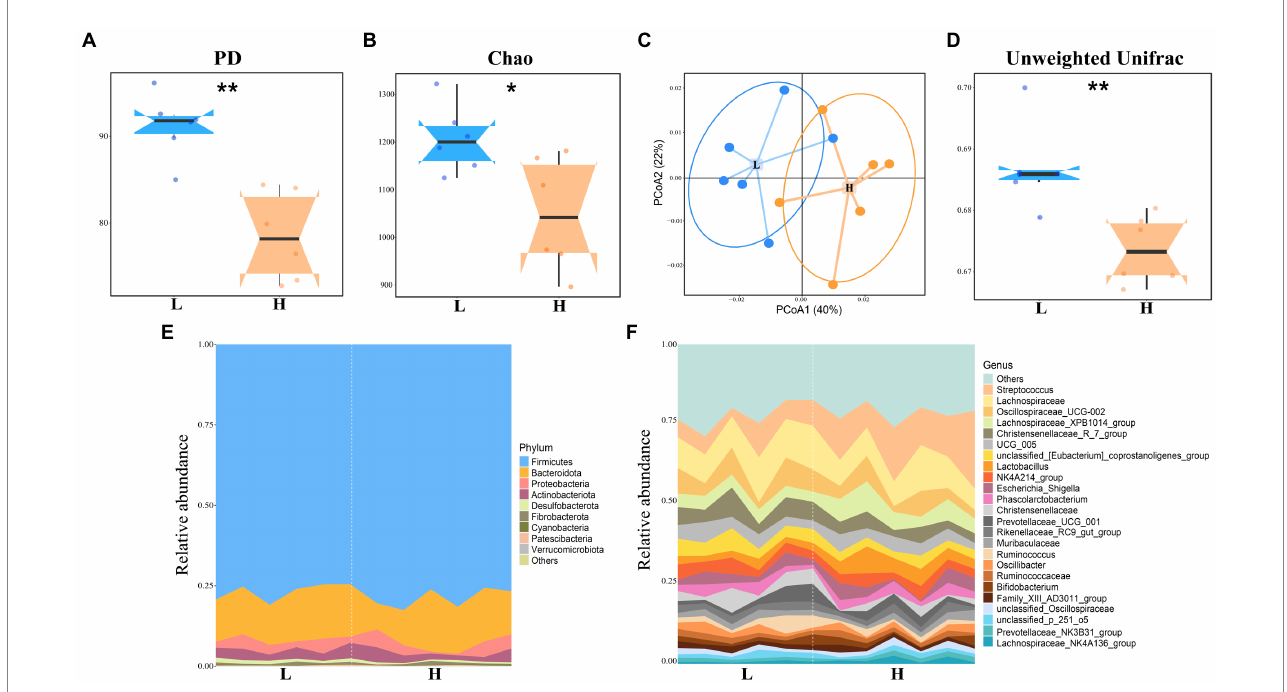
FIGURE 1 Alpha, beta-diversity comparison, and microbial composition among low and high finishing weight groups. (A) Comparison of PD index for two groups. (B) Comparison of Chao index between two groups. (C) Principal Coordinate Analysis (PCoA) analysis for gut microbial community structures based on Unweighted Unifrac distance. (D) Unweighted Unifrac distance metric. (E,F) The gut microbial composition for low and high finishing weight DSE pigs in phylum (E) and genus (F) levels. The box means the interquartile range, and the box with the midline represented the median. “L” and “H” represent low and high finishing weight, respectively; “*” FDR adjusted p < 0.05, “**” FDR adjusted p <